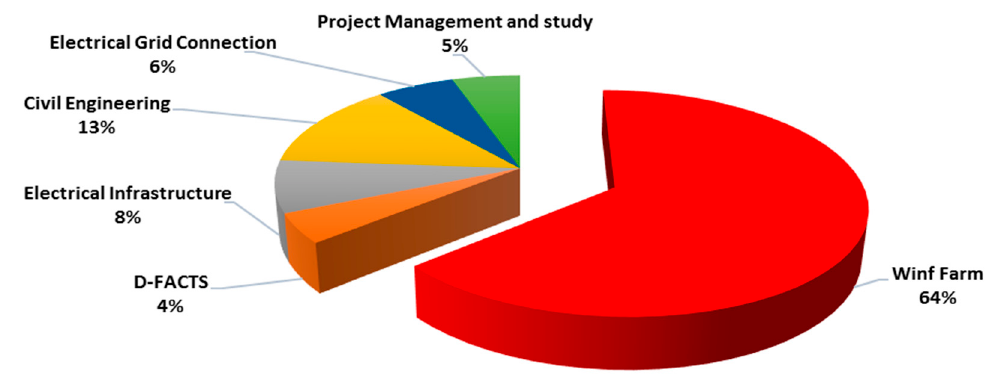
Figure 22. Breakdown of the costs of the wind project.